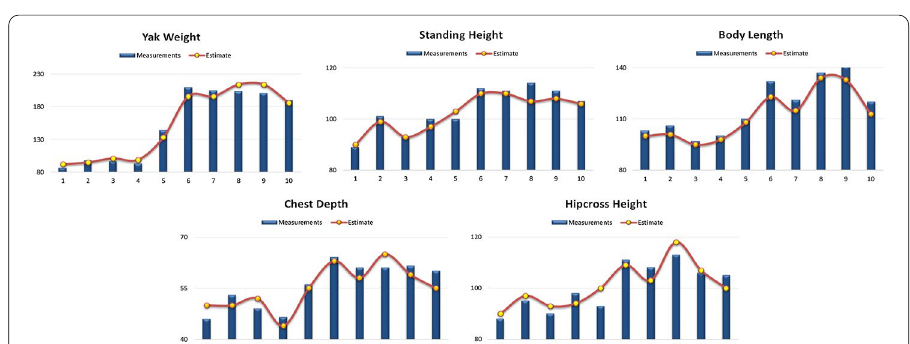
Fig. 7 Body measurement data analysis for yaks in different age groups